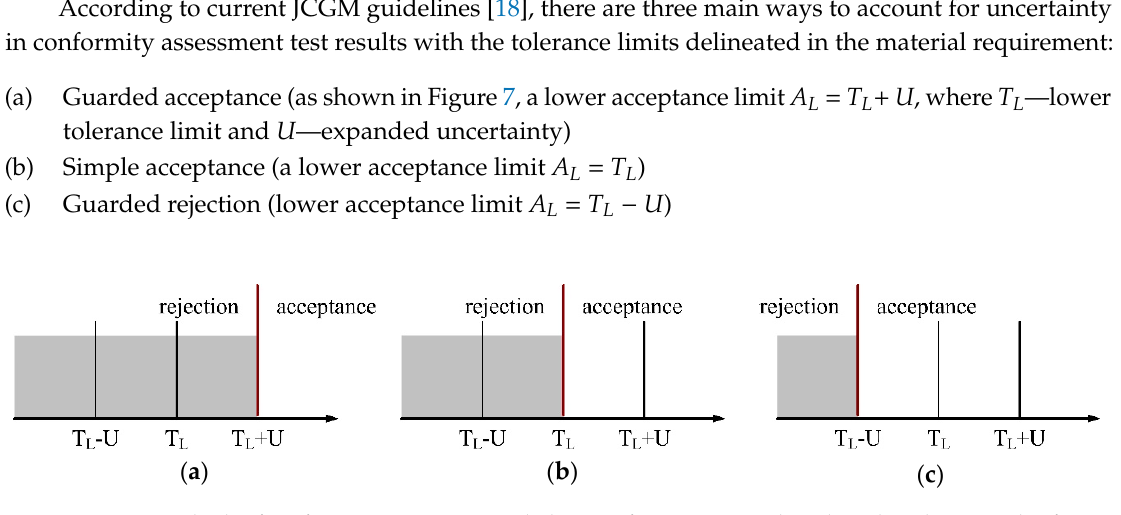
Figure 7. Methods of conformity assessment with the use of uncertainty values, based on the example of the lower tolerance limit T L . ( a )—guarded acceptance; ( b )—simple acceptance; ( c )—guarded rejection. U—expanded uncertainty value.